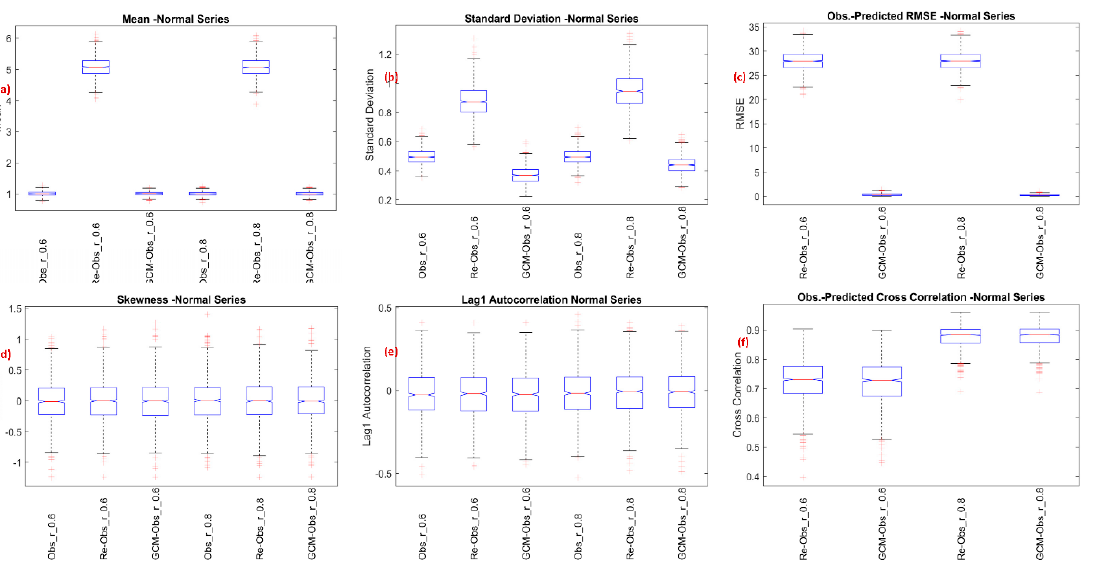
Figure 2. Comparison of predicted data with observed values using the Re-Obs and GCM-Obs models for Set1. Similarity of prediction with observed is showed by ( a ) Mean ( b ) Standard Deviation ( c ) RMSE ( d ) Skewness ( e ) Lag1 autocorrelation and ( f ) Cross correlation. Suffix 0.6 and 0.8 on X-axes labels show the correlation between observed and GCM data considered for synthetic series generation.